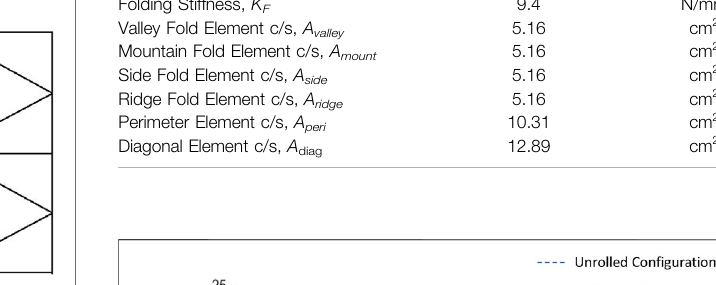
FIGURE 4 | Schematics to determine (A) Bend angle ( θ b ) and (B) Fold angle( θ